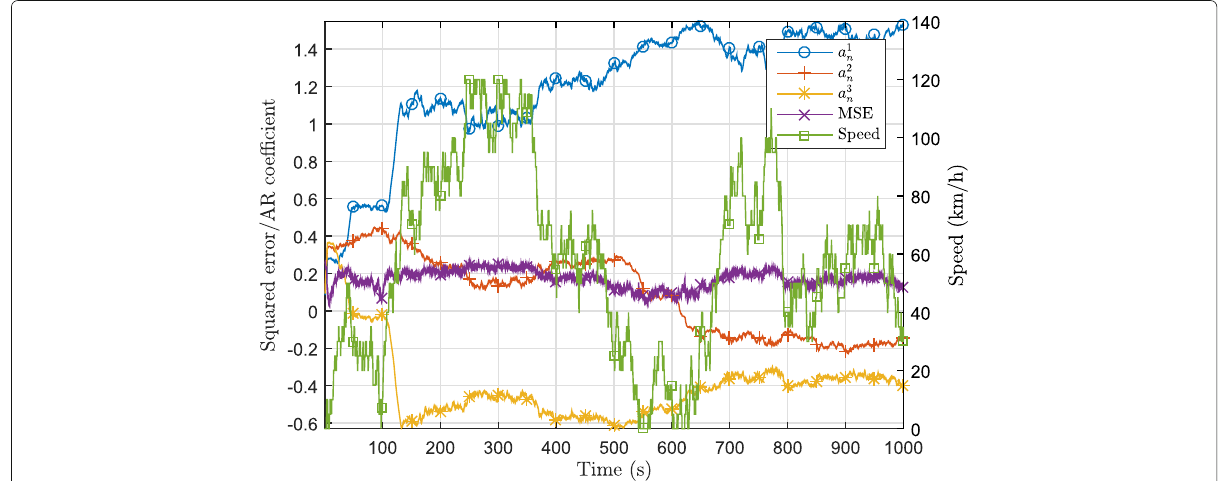
Fig. 13 Example of a simulation with a third-order AR model and the M3 mobility model. SIR is 2.2 dB